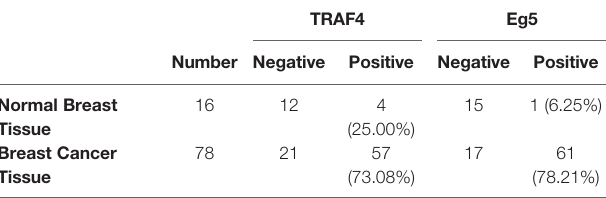
TABLE 1 | The protein level of TRAF4 and Eg5 in